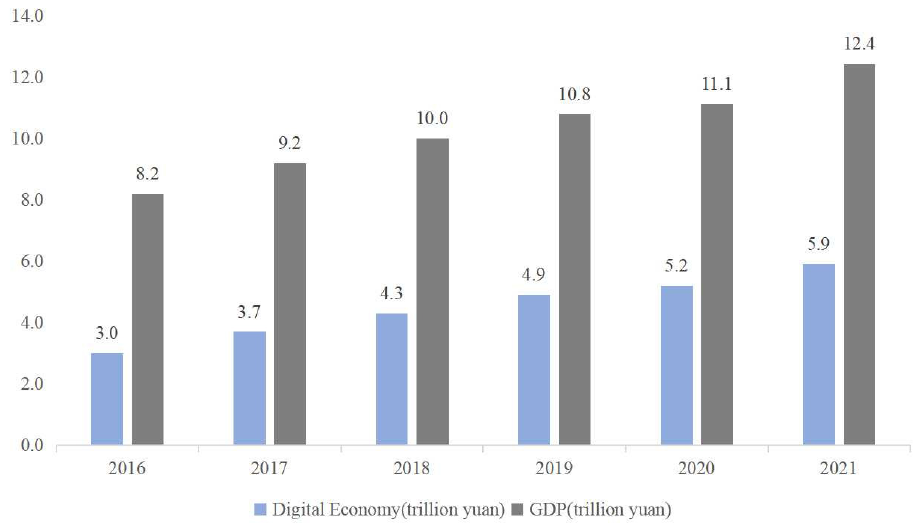
Figure 1. The scale of the digital economy in Guangdong Province and the GDP of Guangdong Province (2016–2021).